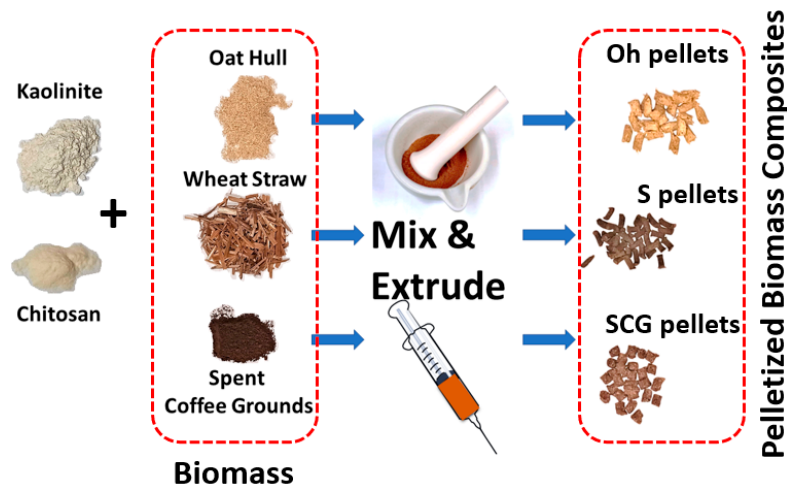
Figure 1. Images of the starting materials: kaolinite, chitosan, oat hulls, torrefied wheat straw and spent coffee grounds (used as received) before grinding, along with a schematic view of the pellet preparation process.